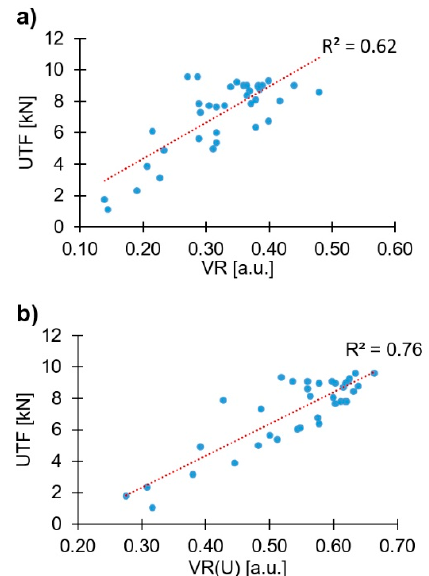
Figure 10. UTF—volumetric ratio plots: ( a ) VR; ( b ) VR(U).